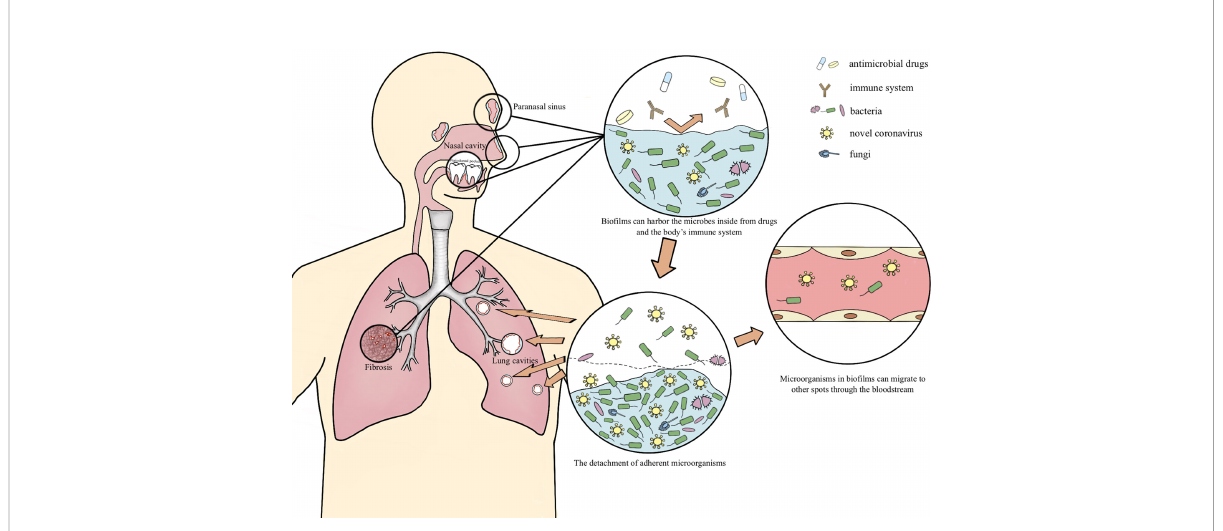
FIGURE 1 The possible mechanism of the long-term retention of SARS-CoV-2 Occult SARS-CoV-2 may coexist with other pathogenic microorganisms in respiratory lacuna (paranasal sinuses, periodontal clearance, bronchioloalveolar necrotic tissue and pulmonary fi brosis tissue, etc.) in the form of bio fi lm, and transfers into the lung then multiply when the body is in an immunocompromised situation, as well as migrates to other organs at the distance of the entrance through the bloodstream, accounting for the cavitation, re-positive and long-term positive nucleic acid tests during the COVID-19